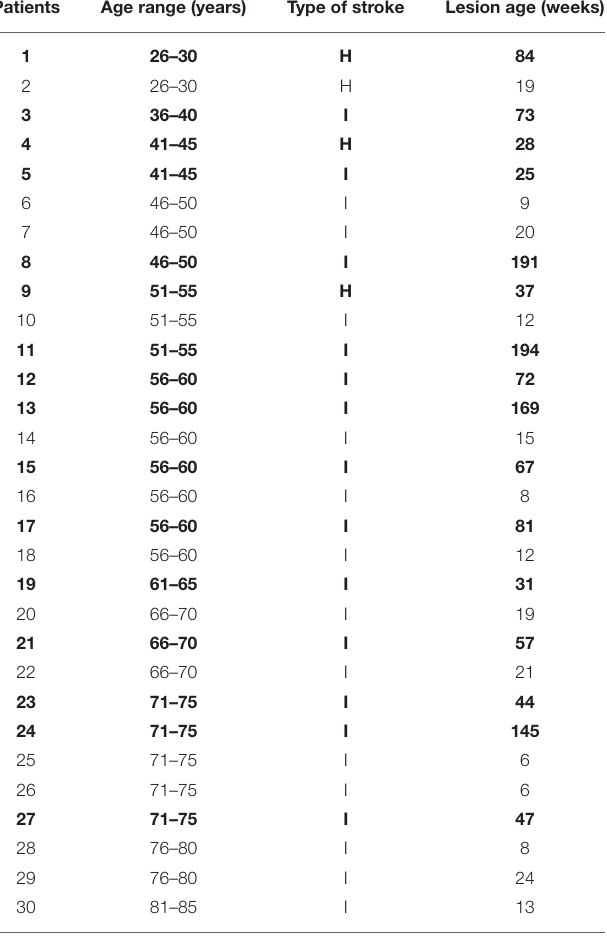
TABLE 1 | Characteristics of the patient sample (I, infarction; H, hemorrhage stroke).